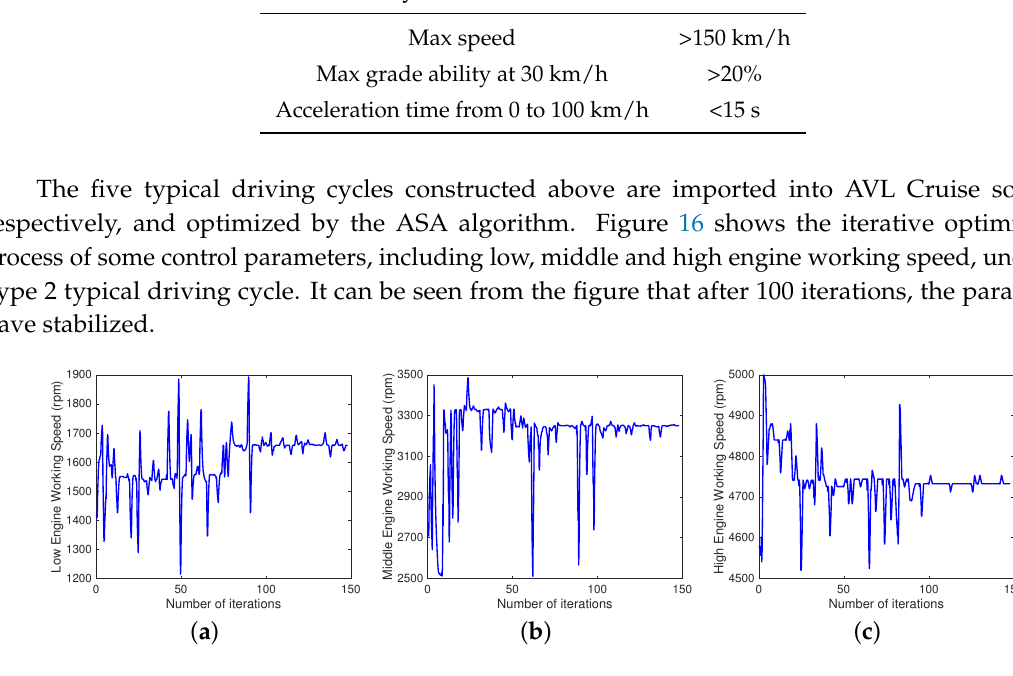
Figure 16. The iterative process of the engine working speeds under the Type 2 typical driving cycle: ( a ) low engine working speed. ( b ) Middle engine working speed. ( c ) High engine working